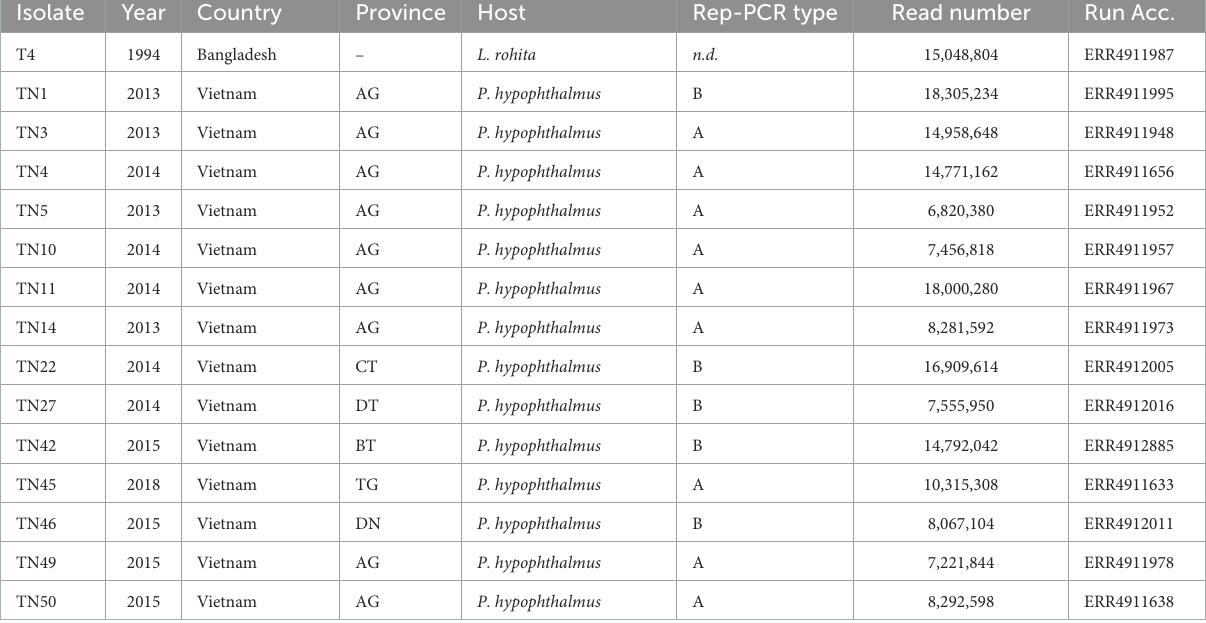
TABLE 1 Field isolate genomes sequenced in this present study. Isolate